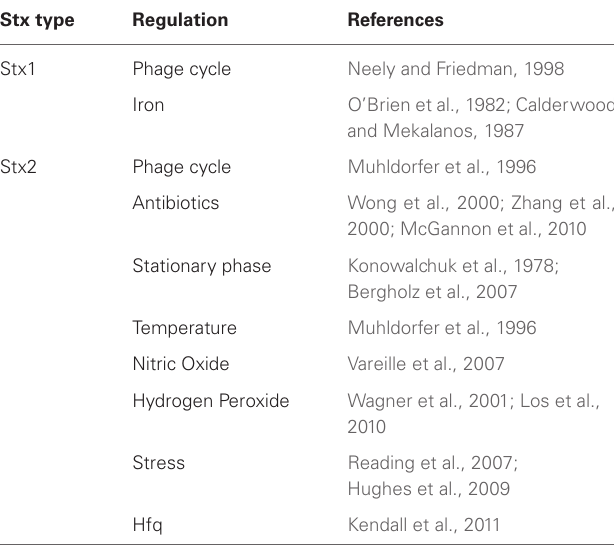
Table 2 | Regulation of Stx